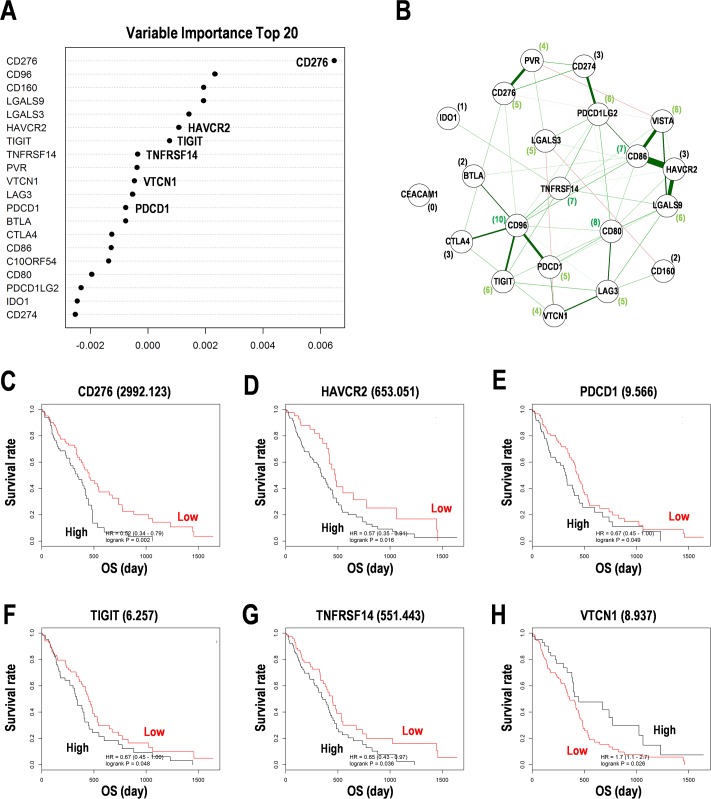
Prognostic marker candidates for immunosuppression in the training data set of glioblastoma multiform (GBM).(A) Random survival forests analysis for immunosuppressive pathway genes in GBM. Top 20 of variable importance were shown. (B) Graphical lasso estimation for the genetic interaction of immunosuppressive pathway genes in GBM. Schematics were drawn by glasso package in R. Numbers in the parentheses indicate the numbers of genetic interaction. Thick and thin lines indicate strong and weak interaction, respectively. (C-H) Kaplan-Meier survival analysis for immunosuppressive pathway genes in GBM. (C) CD276/B7-H3. (D) HAVCR2/TIM-3. (E) PDCD1/PD-1. (F) TIGIT. (G) TNFRSF14. (H) VTCN1. Numbers in the parentheses indicate the threshold of gene expression. High and low indicate subgroups with over and under the threshold. OS, overall survival. HR, hazard ratio. Subgroups were divided by the median expression of genes.